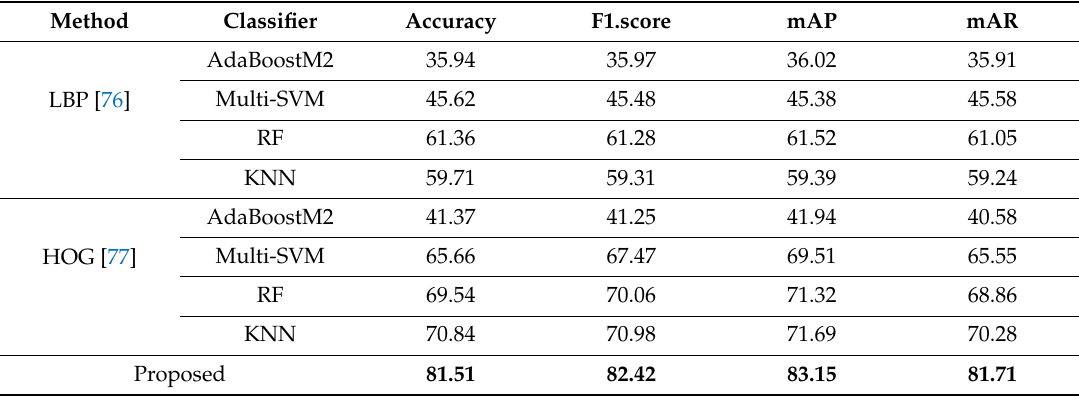
Table 9. Comparison of classification performance of the proposed method with different handcrafted feature-based methods (unit: %).